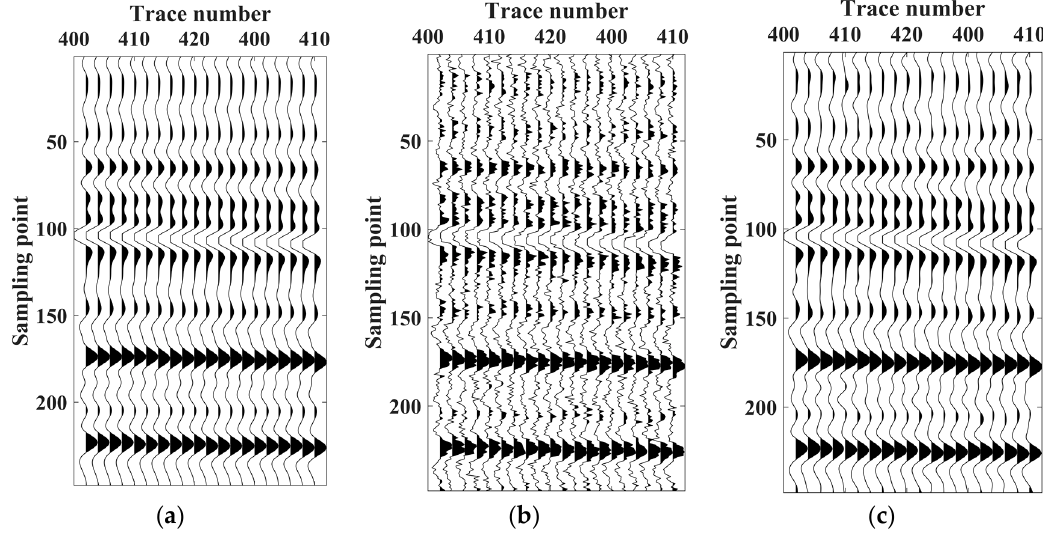
Figure 5. The synthetic seismic data. ( a ) The Marmousi2 model; ( b ) Noisy data; and, ( c ) GMHDD.